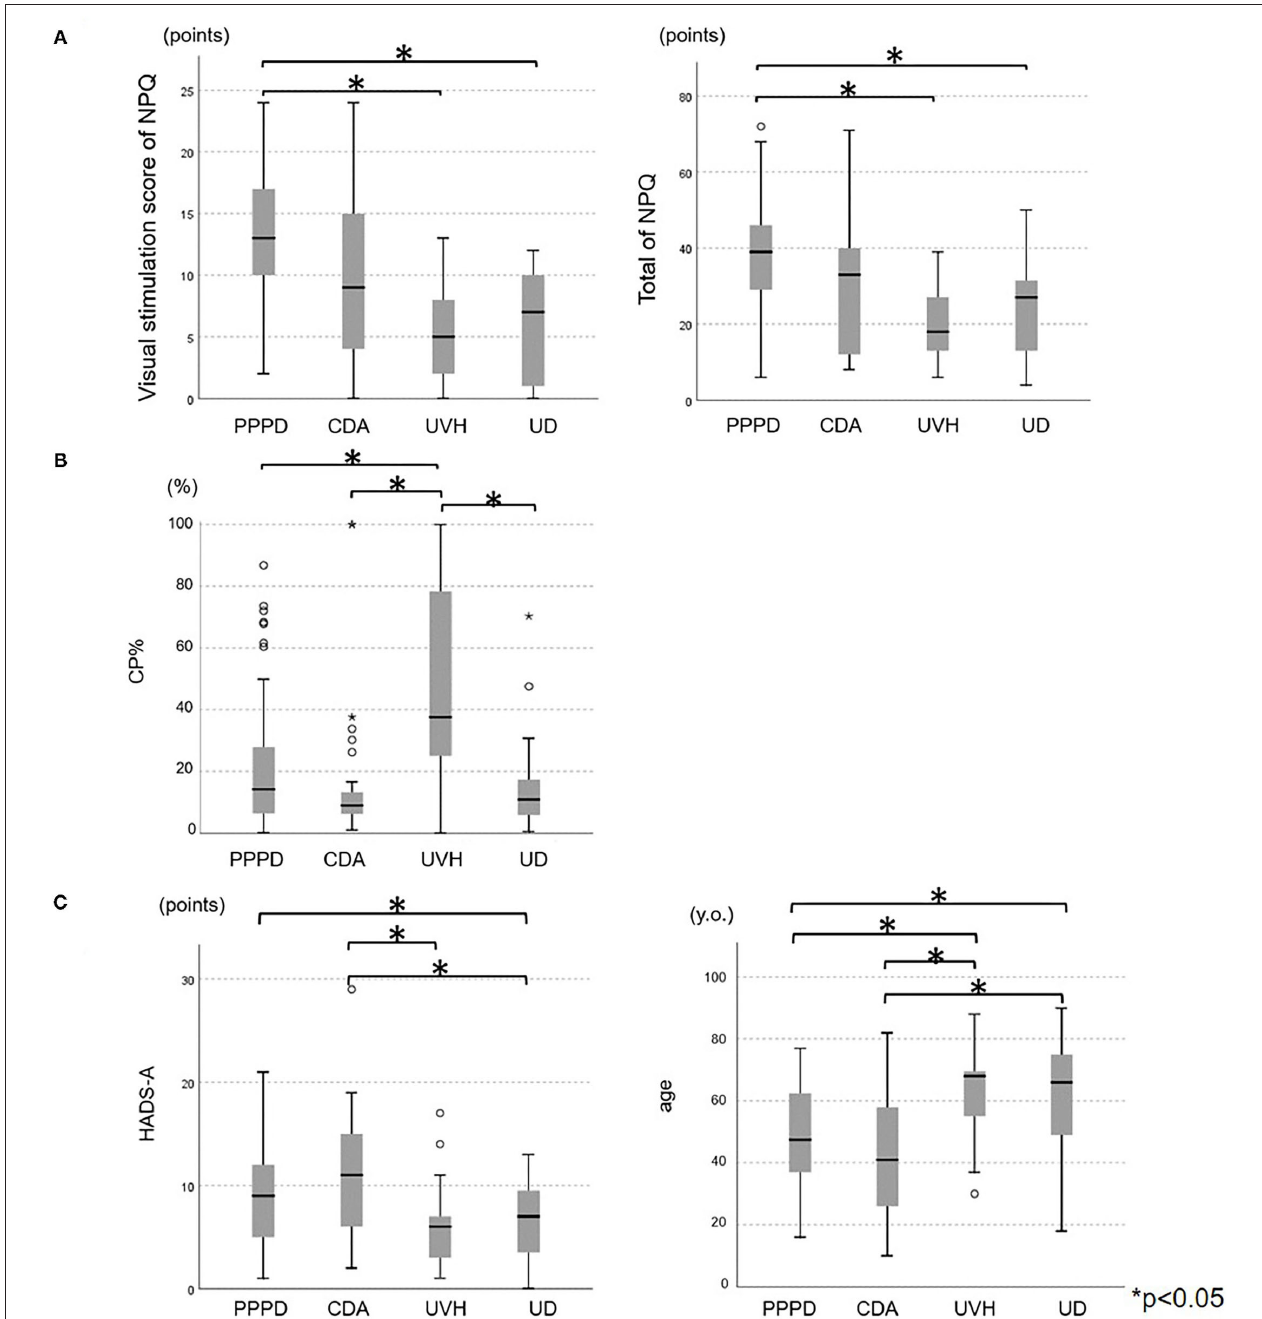
FIGURE 1 | Comparisons of the (A) NPQ scores, (B) CP%, and (C) HADS-A score and age among the chronic vestibular syndromes. (A) The visual stimulation score of the NPQ of the PPPD group (13.05 ± 5.21) was significantly higher than that of the UVH (5.27 ± 4.08) ( p < 0.05) and UD groups (6.20 ± 4.78) ( p < 0.05). The total score of the NP of the PPPD group (37.70 ± 13.51) was significantly higher than that of the UVH (19.80 ± 9.95) ( p < 0.05) and UD groups (24.20 ± 14.90) ( p < 0.05). (B) The CP% of the UVH group (51.81 ± 32.38) was significantly higher than that of the PPPD group (20.17 ± 19.59) ( p < 0.05), CDA group (16.57 ± 22.82) ( p < 0.05), and UD group (14.94 ± 15.25) ( p < 0.05). (C) The HADS-A score of the CDA group (11.15 ± 5.89) was significantly higher than that of the UVH group (6.04 ± 3.85) ( p < 0.05) and UD group (6.19 ± 3.53) ( p < 0.05). The HADS-A score of the PPPD group (9.18 ± 4.70) was significantly higher than that of the UD group (6.19 ± 3.53) ( p < 0.05). The patients in the CDA group (42.4 ± 18.9 years) were significantly younger than those in the UVH group (63.5 ± 13.3 years) ( p < 0.05) and UD group (60.2 ± 19.7 years) ( p < 0.05). The patients in the PPPD group (48.3 ± 15.2 years) were significantly younger than those in the UVH group (63.5 ± 13.3 years) ( p < 0.05) and UD group (60.2 ± 19.7 years) ( p < 0.05). NPQ, Niigata PPPD questionnaire; CP%, percentage of canal paresis; HADS-A, anxiety score on the hospital anxiety and depression scale; PPPD, persistent postural-perceptual dizziness; CDA, chronic dizziness due to anxiety; UVH, unilateral vestibular hypofunction; UD, undifferentiated